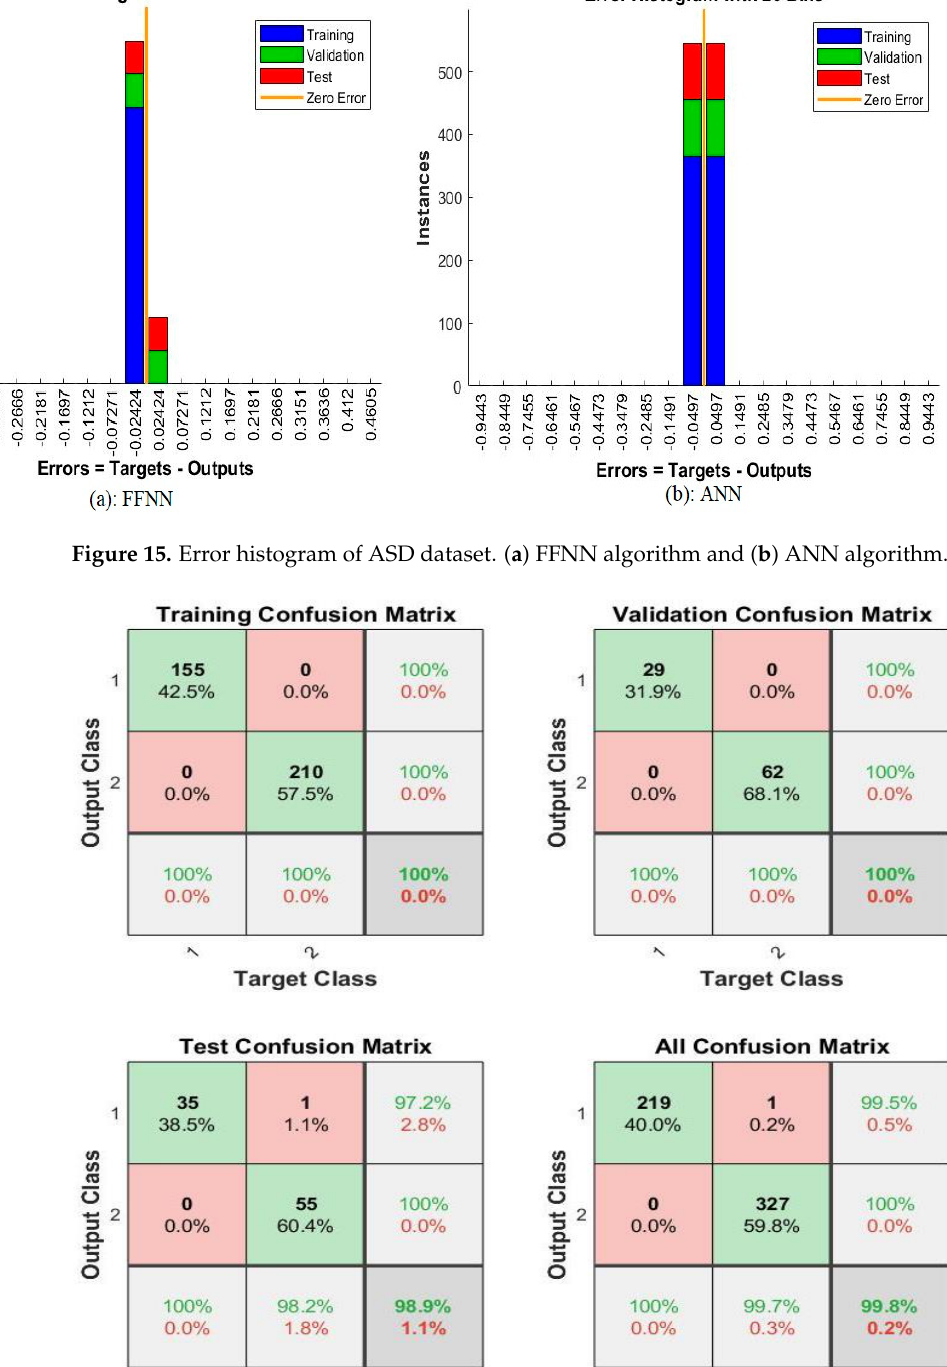
Figure 14. Regression plot of ASD dataset by FFNN.